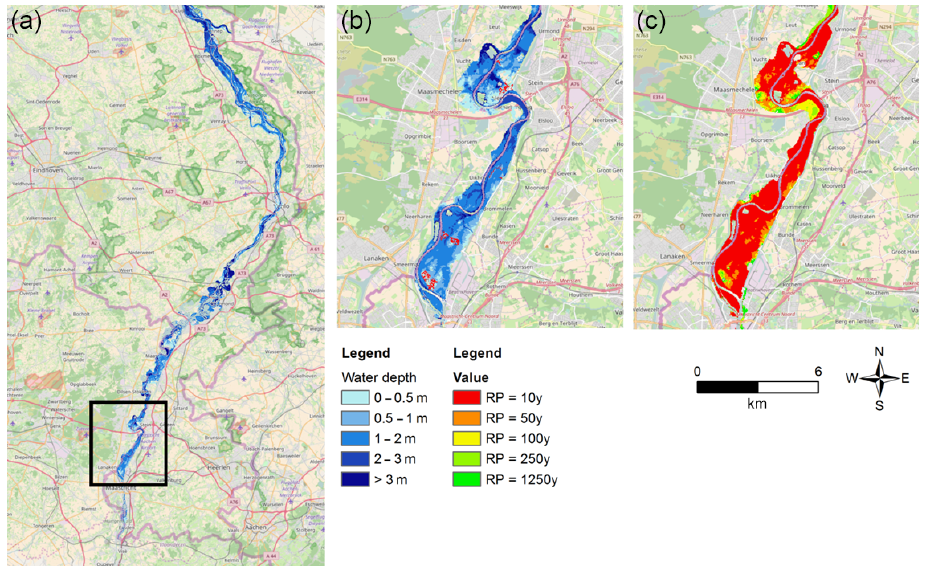
Figure 2. (a) Simulated water depth for the entire study area in Limburg. (b) Simulated water depth and affected population (in red) for an example area. (c) The return period at which areas start flooding for the example area. The example area is defined in the box in the left picture. The scale bar corresponds to the example